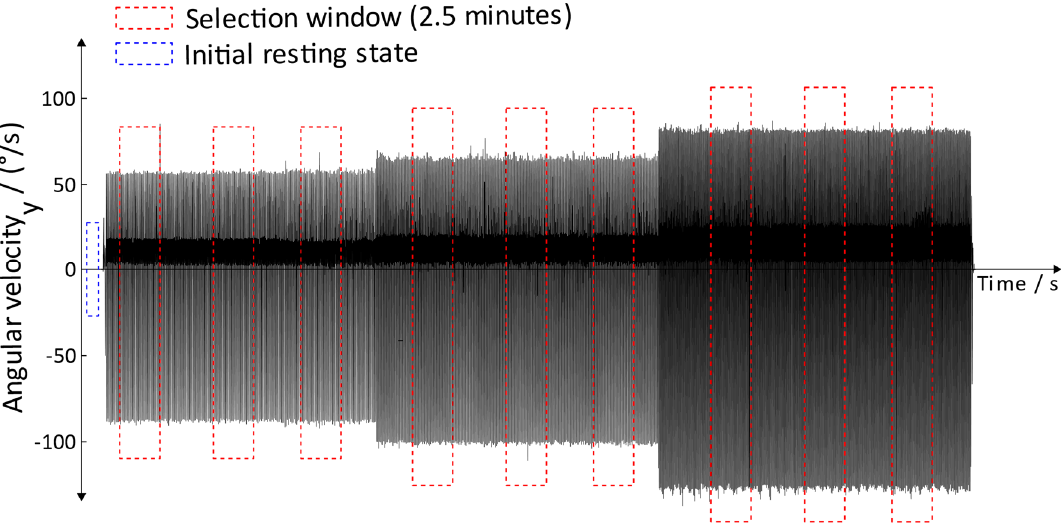
Figure 21. Selection method for analyzing data .